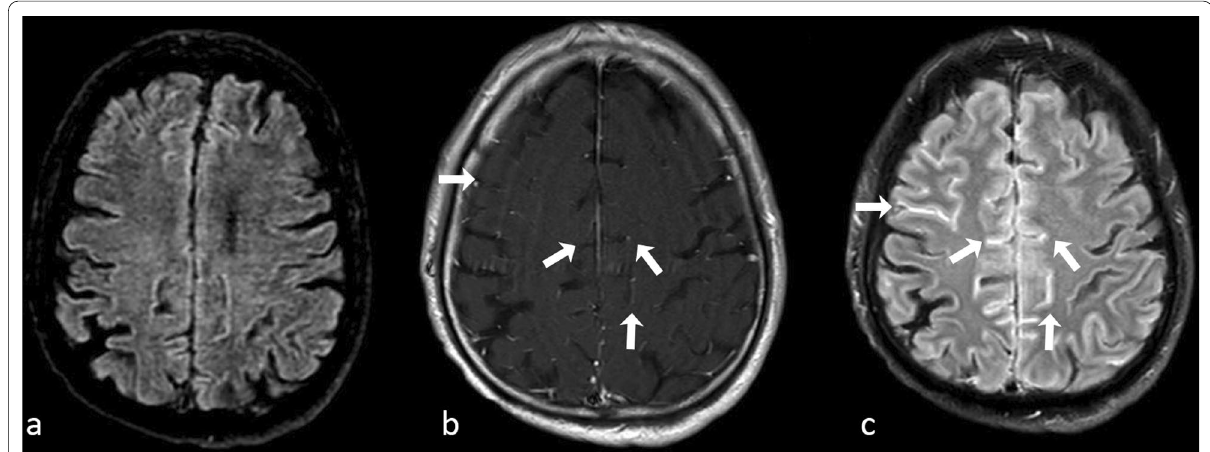
Fig. 15 25-year-old female patient with suspected meningitis. Nonenhanced fluid attenuated inversion recovery (FLAIR) a image appears negative. Turbo spin echo (TSE) T1-w. magnetization transfer scan b is inconclusive, although mild effacement of some frontal and parietal sulci can be suspected (arrows). On contrast-enhanced FLAIR ( c ) scan extensive hyperintensity of several sulci can be easily diagnosed